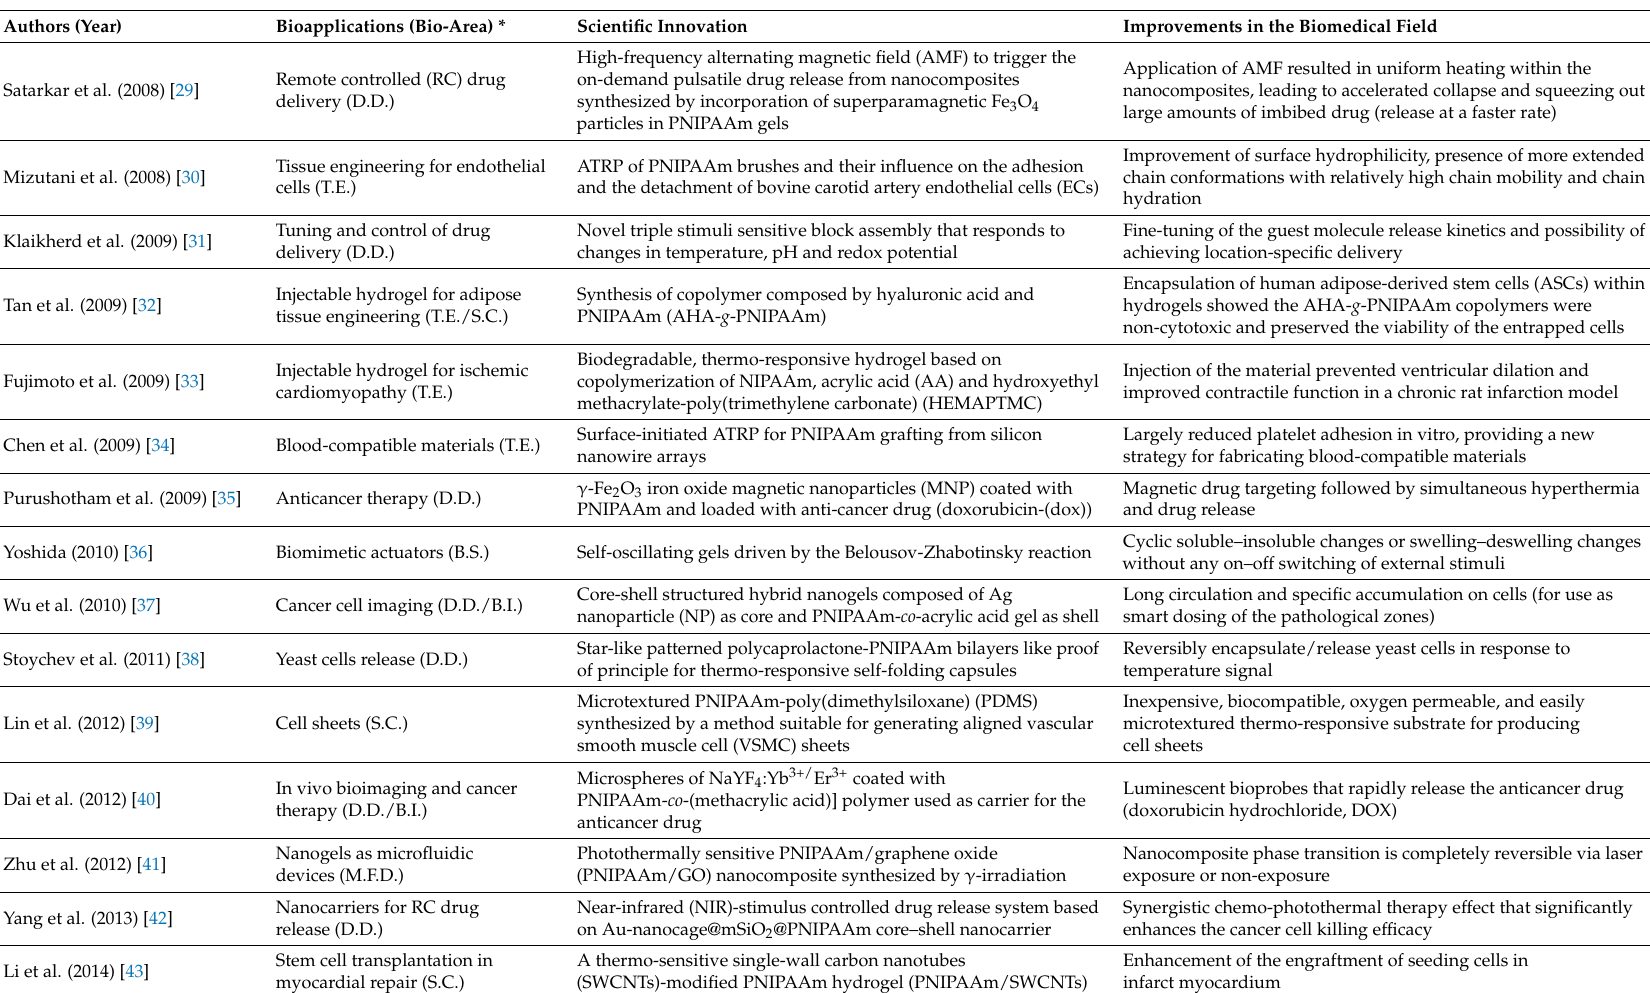
Table 1. Overview of some relevant publications on poly( N -isopropylacrylamide) (PNIPAAm) copolymerization and its biomedical applications over the past 10 years. Authors